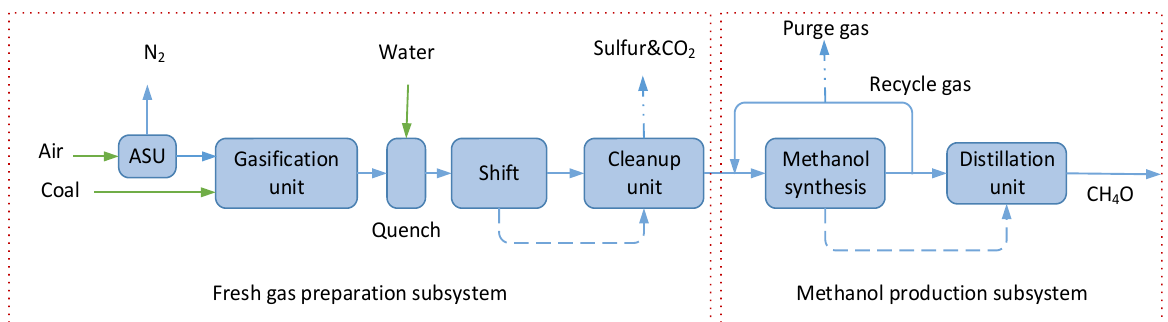
Figure 2. Flow diagram of coal-based methanol production.